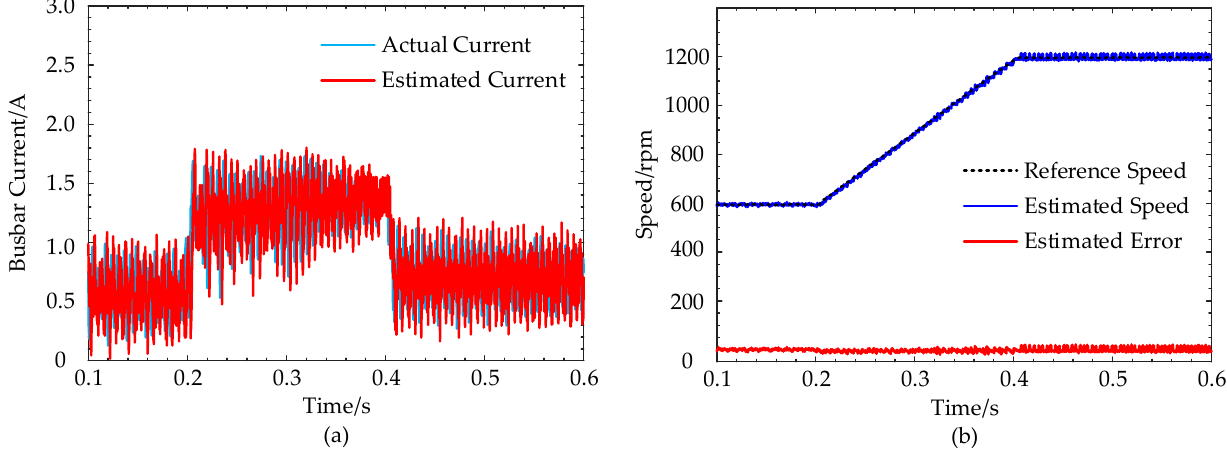
Figure 12. STA observer experimental results: ( a ) estimated and actual current curves; ( b ) reference and estimated speed curves.